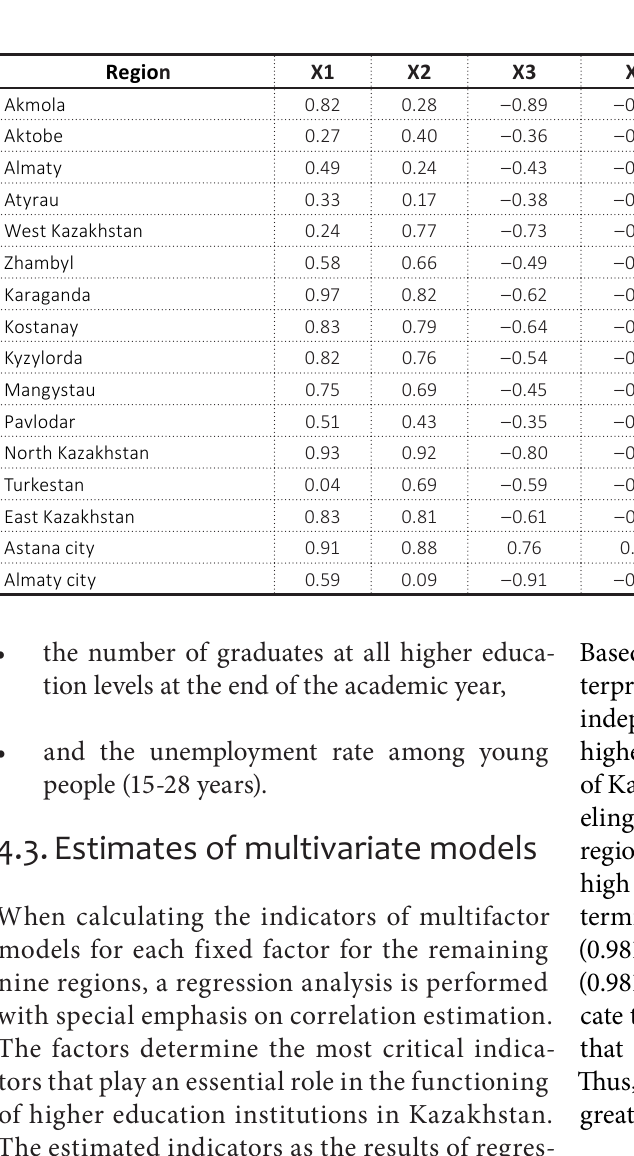
Table 3. Correlation matrix of multifactor models by regions of Kazakhstan for 2002–2021